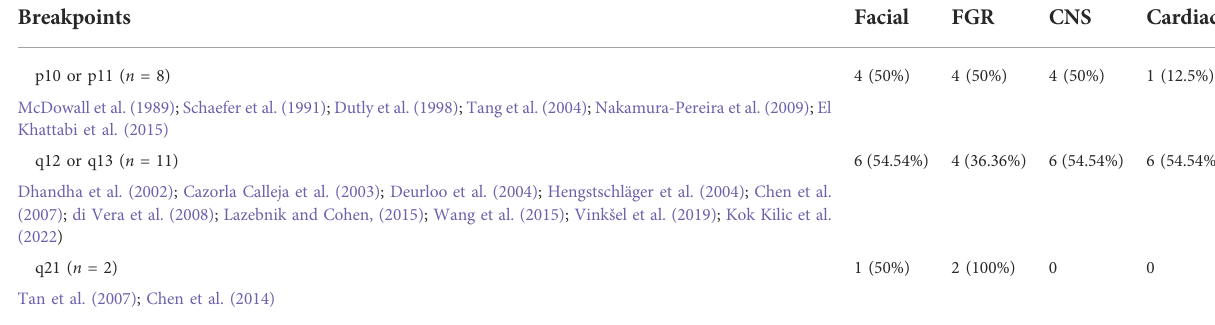
TABLE 1 Malformations in relation to breakpoints among prenatal cases associated with T9p. Breakpoints Facial FGR CNS Cardiac